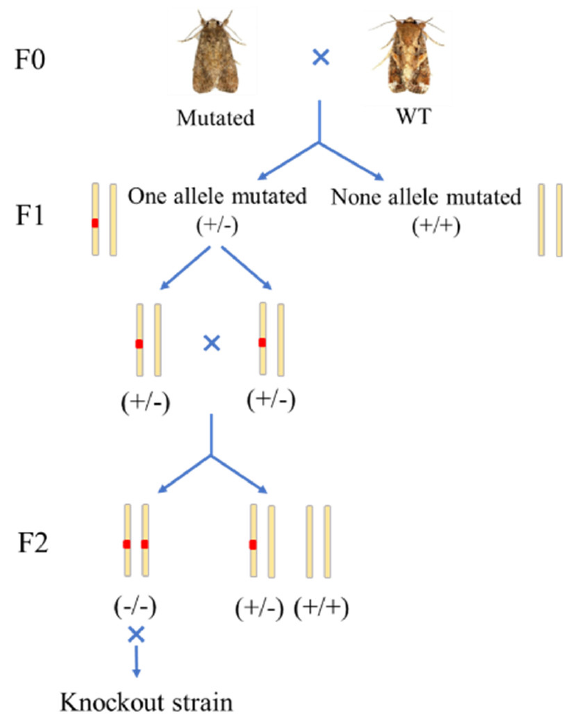
Figure 2. The procedures of FGFR−KO and SRC−KO establishment. The FGFR (fibroblast growth factor receptor) consists mainly of three extracellular Ig-like domains and one intracellular tyrosine split kinase domain [35]. Our FGFR-KO strain deleted 8 bp and inserted 2 bp, resulting in two amino acids deletion in the Ig-like I domain (Figure 3A). It should be mentioned that the mating and hatching rate of that the knockout strain FGFR-KO was decreased after rearing several